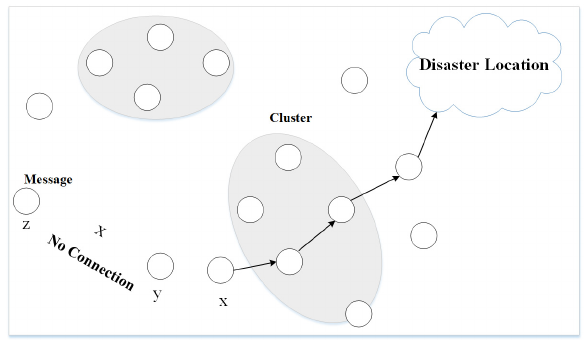
Figure 5. Cluster-based message transmission. Figure 5. Cluster ‐ based message transmission. Figure 5. Cluster ‐ based message transmission.